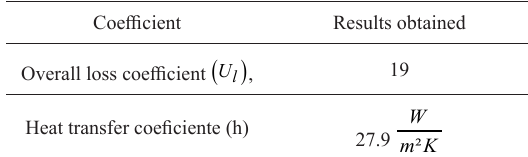
Table 3. Manufacturer`s data 14 . Table 4. Results obtained for the